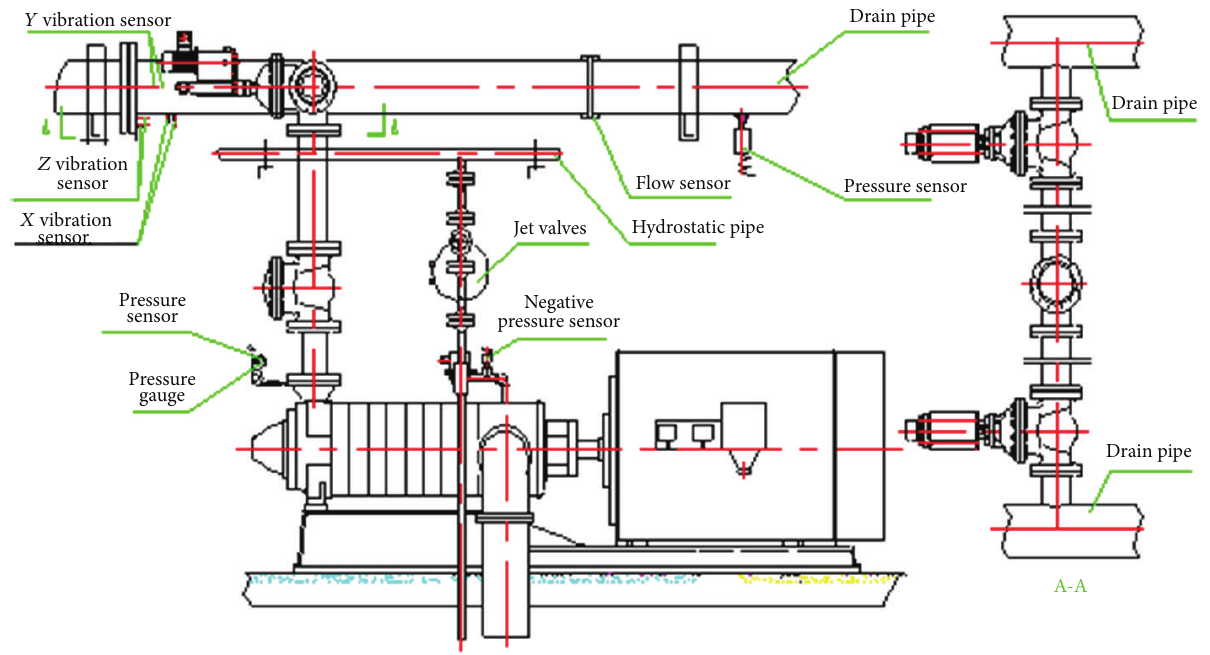
Figure 21: Arrangement diagram of sensors.